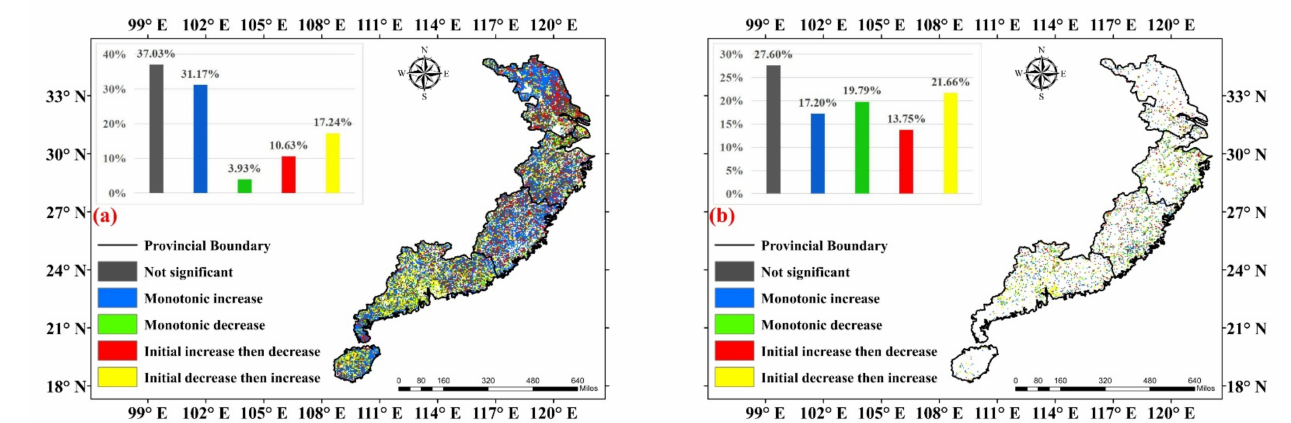
Figure 8. Spatial distribution of the non-linear trend of the vegetation NPP changes: ( a ) unchanged vegetation types, and ( b ) changed vegetation types. The white areas in ( a , b ) representing the changed and unchangedvegetation types, respectively.